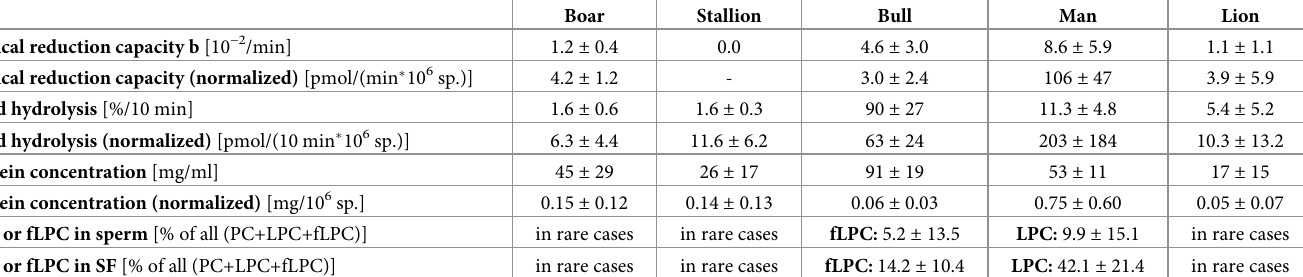
Table 2. Radical reduction capacity of seminal fluid (SF), phospholipase A2 activity, protein concentration and occurrence of lyso-glycerophosphatidylcholine (LPC) and formyl-LPC (fLPC) in organic extracts of sperm and SF of different species.